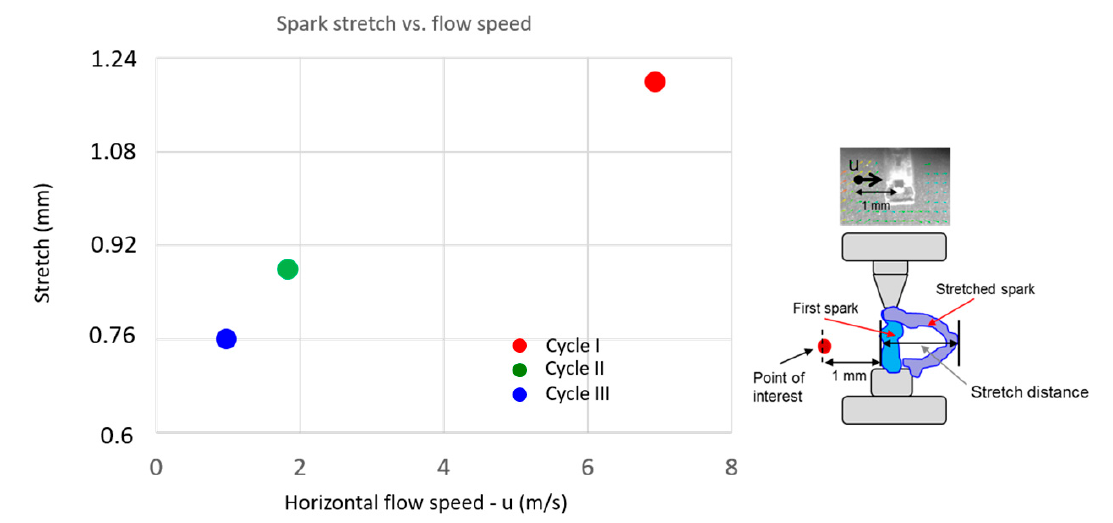
Figure 5. Flow speed and spark stretch relationship at 1200 rpm operating condition. Also shown is an illustration for the calculation of stretch distance and flow speed determination.